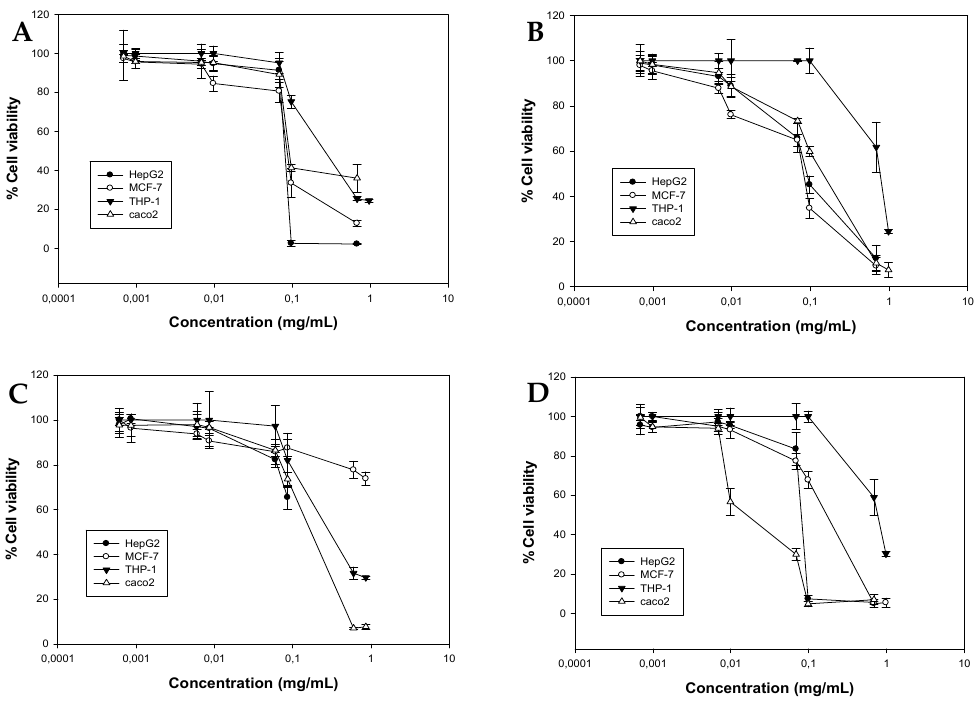
Figure 1. Antiproliferative activity of ( A ) anise ( B ) spearmint ( C ) kumquat ( D ) sweet basil oils against a panel of four human cancer cell lines. Cancer cells were incubated with increasing concentrations of the oils for 72 h. Estimation of cell viability was determined by the SRB assay. Representative figures of at least three experiments.